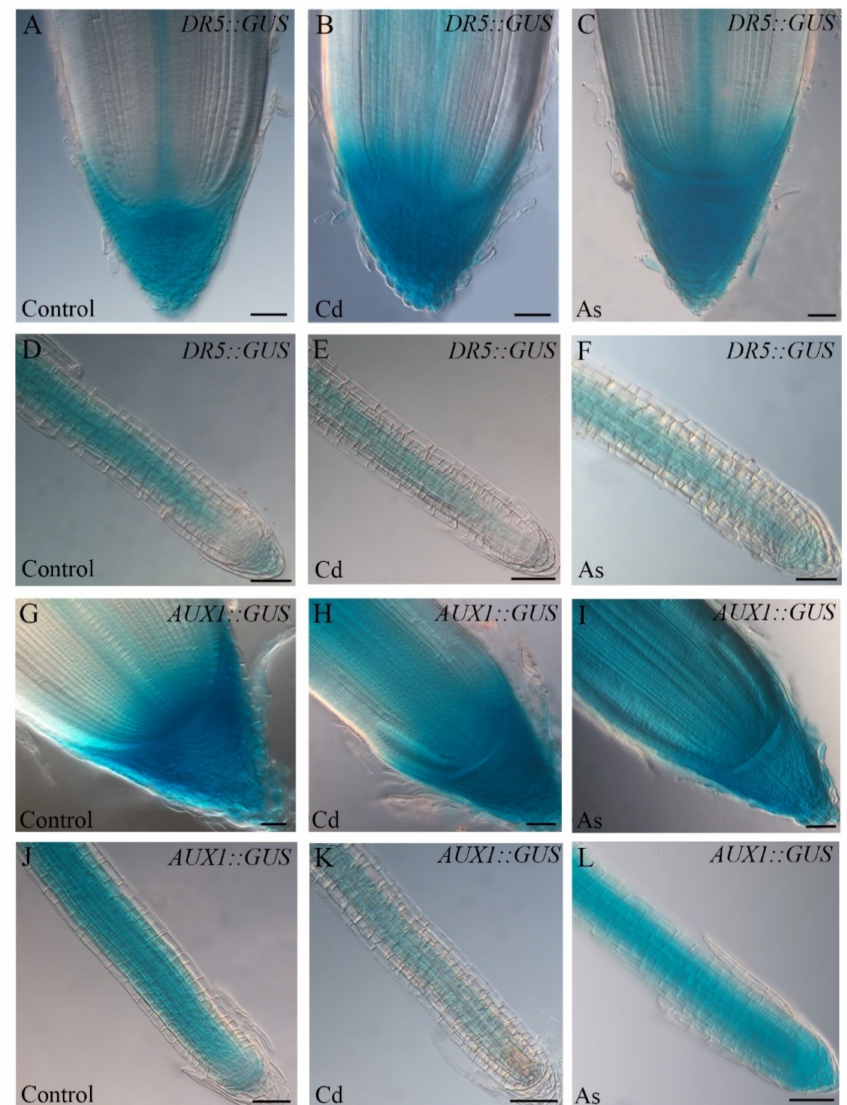
Figure 3. Expression patterns of DR5::GUS and AUX1::GUS in adventitious roots (ARs, ( A – C , G – I )) and lateral roots (LRs, ( D – F , J – L )) of Oryza sativa DR5::GUS and AUX1::GUS seedlings non-exposed (Control, ( A , D , G , J )) or exposed to 100 µ M CdSO 4 (Cd, ( B , E , H , K )) or 100 µ M Na 2 HAsO 4 · 7H 2 O (As, ( C , F , I , L )). Bars = 40 µ